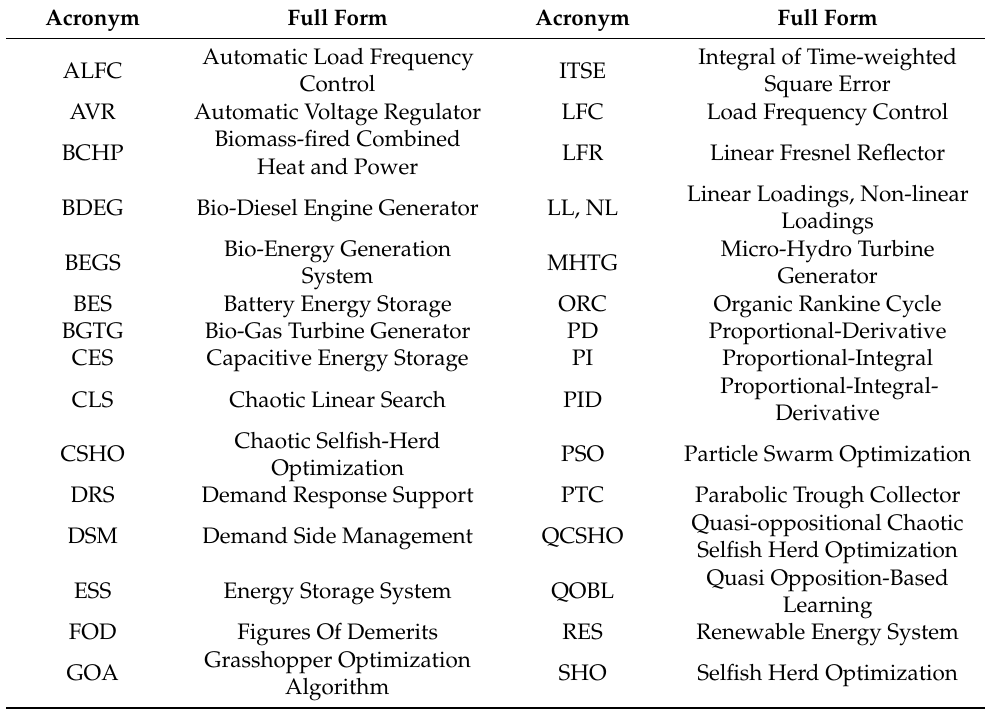
Table 7. List of